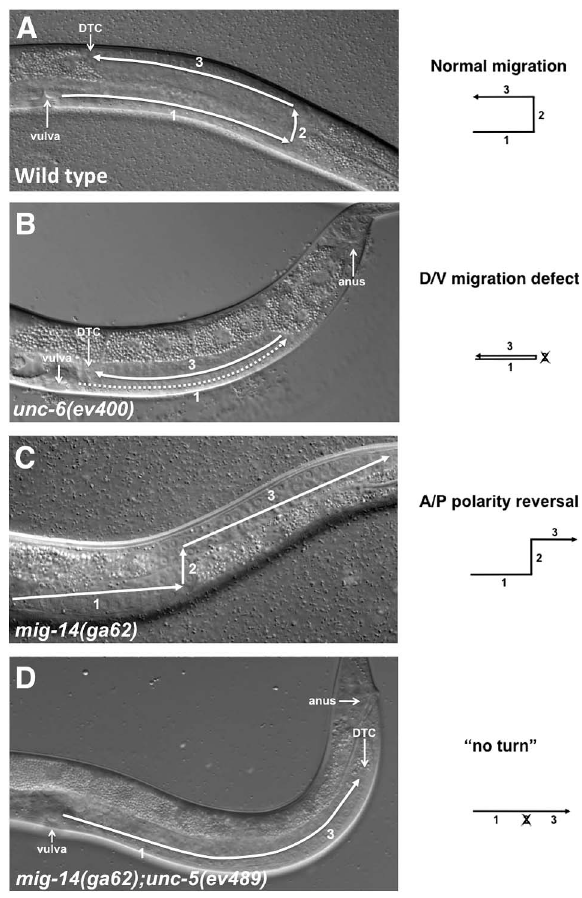
Figure 1. Netrin signaling components and Wntless are involved in guiding DTC migrations. DIC images show migrations of the posterior DTC in L4 stage hermaphrodites. In all panels anterior is left and dorsal is up. (A) In the wild type a posterior U-shaped gonad arm is formed by 3 sequential migratory phases of the posterior DTC. The anterior DTC (not shown) undergoes a mirror image symmetrical pattern of migration. (B) In unc-6(ev400) the posterior DTC frequently fails to execute the phase 2 ventral to dorsal migration resulting in a ‘ventralized’ gonad arm. The anterior DTC of these mutants (not shown) also exhibits these phase 2 failures, but at a lower frequency than the posterior DTC. The dashed line represents the gonad segment formed in phase 1 that overlaps the segment formed in phase 3. (C) In mig- 14(ga62) the first and second phases of migration are normal, but at the onset of phase 3 the DTC frequently displays a polarity reversal and migrates away from the mid-body instead of towards it. In some cases the DTC initially turns towards the mid-body and subsequently reverses its polarity (Figure S1). (D) In mig-14(ga62); unc-5(ev489) animals, the posterior DTC frequently fails to execute phase 2 migration; this together with subsequent phase 3 polarity reversals cause a ‘no turn’ phenotype. The diagrams depict the migratory pattern of the posterior DTCs corresponding to the phenotypes shown in the DIC images.